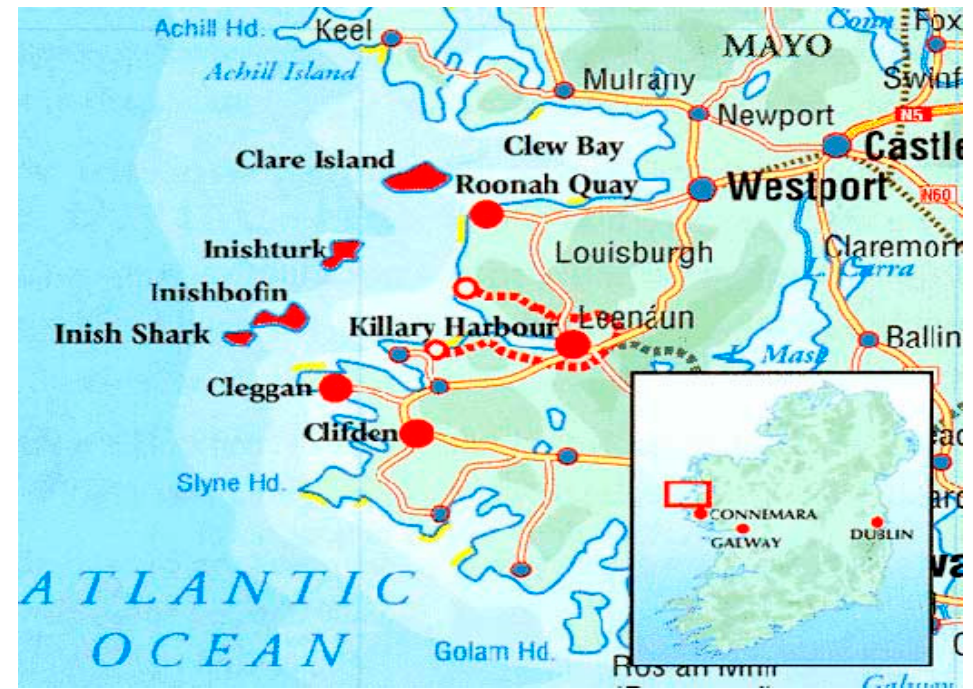
Figure 1. Connemara Region and main town of Clifden [12].